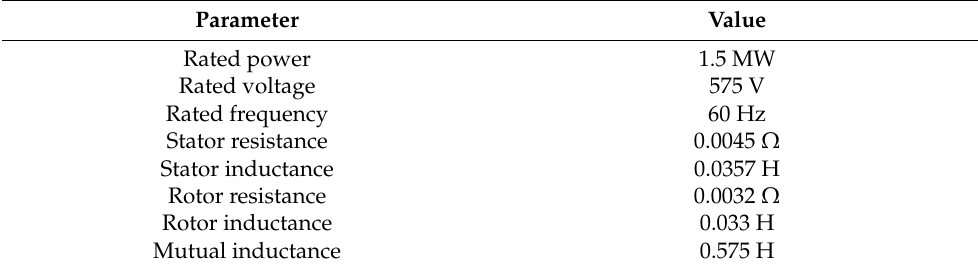
Table A1. DFIG data.